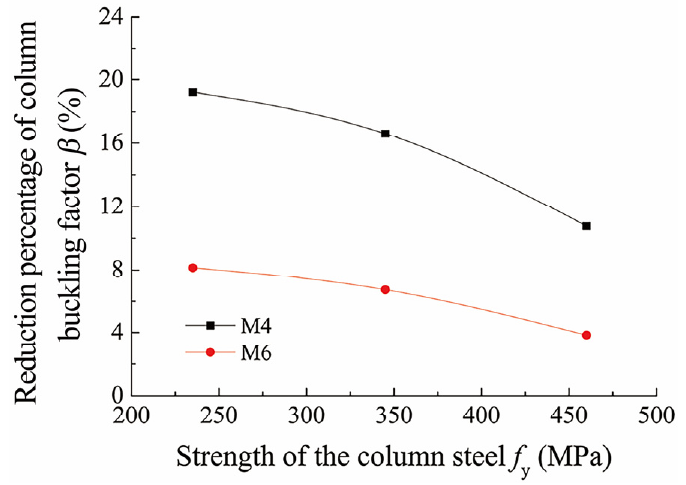
Figure 6. Influence of initial geometric imperfection on the stability of columns with various steel strengths.